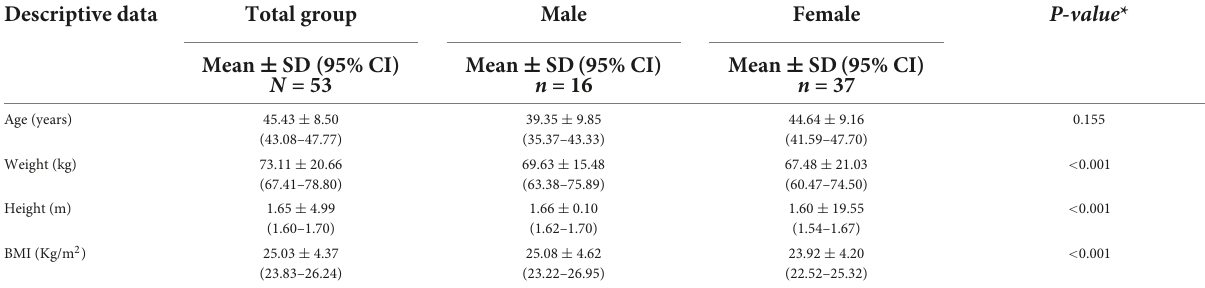
TABLE 1 Descriptive data of the participant’s total population.